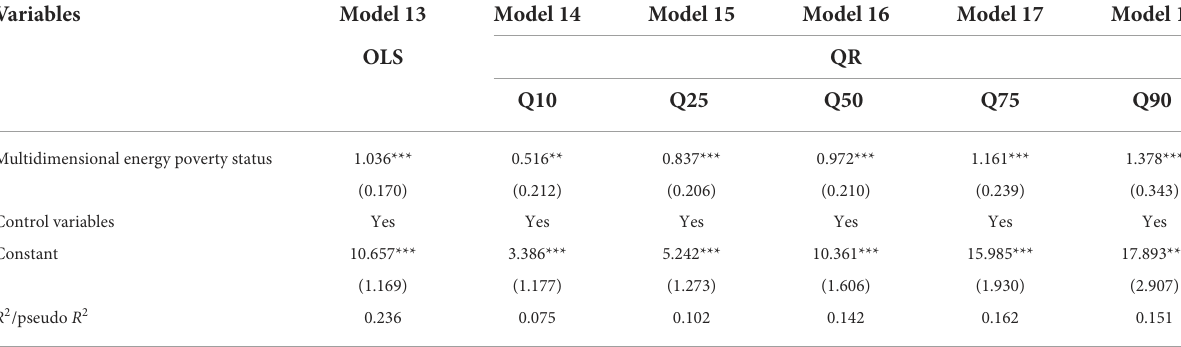
TABLE 5 Regression results by replacing core explanatory variable.